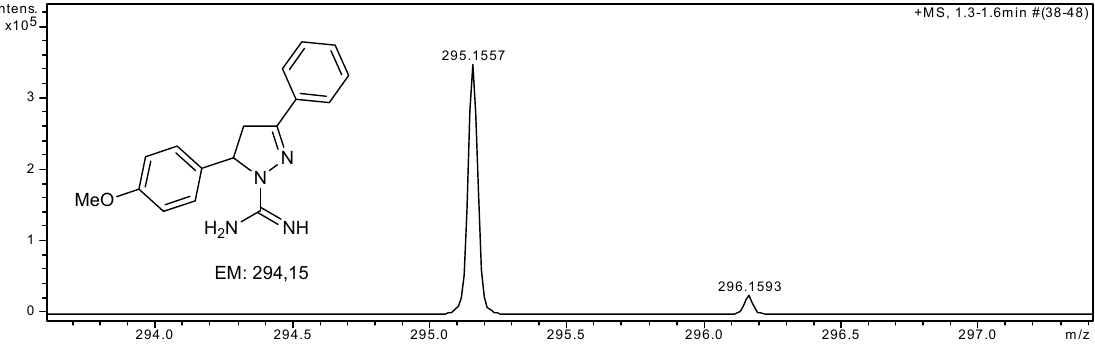
Figure 1. Representative HRMS spectrum of 5-(4-methoxyphenyl)-3-phenyl-4,5-dihydro- 1 H -pyrazole-1-carboximidamide ( 1 ).